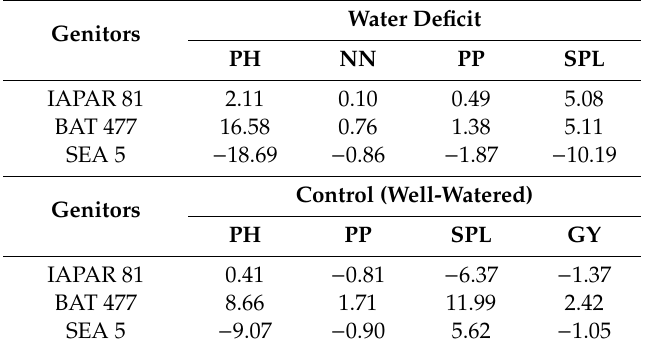
Table 3. Estimates of general combining ability ( ˆ g i ) e ff ects evaluated for drought-tolerant common bean genotypes cultivated under water deficit and control condition (well-watered). Genitors